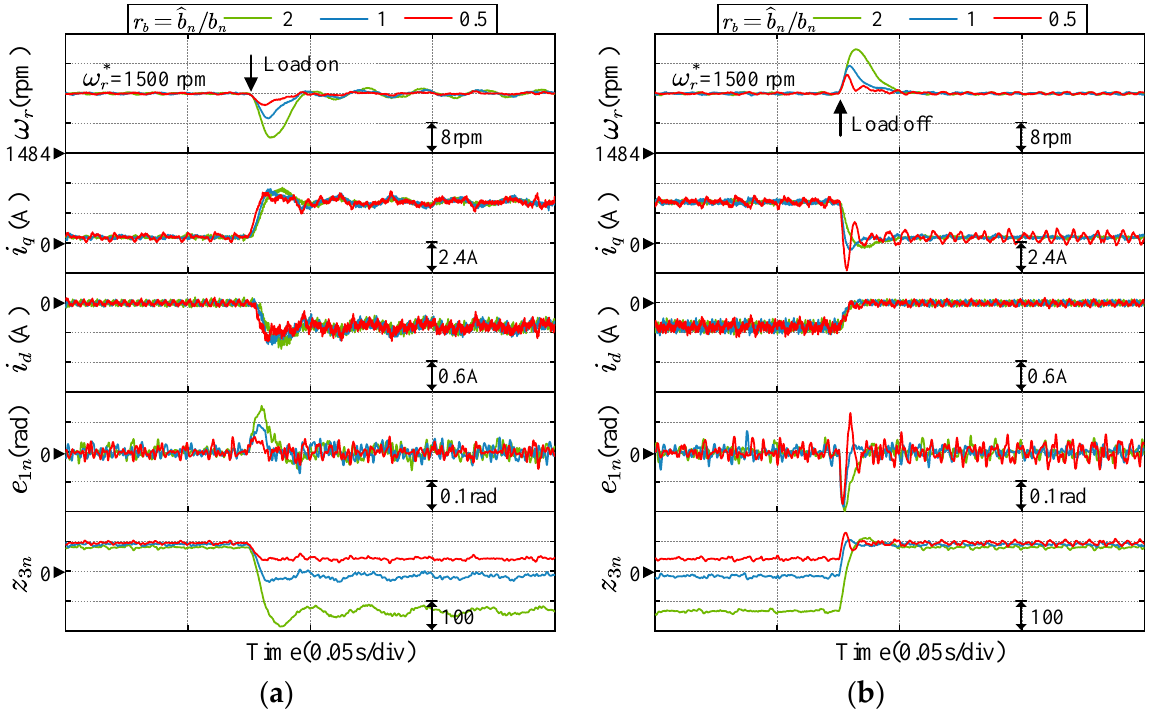
Figure 18. Experimental results of the speed response with step load disturbance under different r where ω 0 n = 120 π , k n = 10 π , r b = [ 0.5, 1, 2 ] . ( a ) Loading; ( b ) unloading.